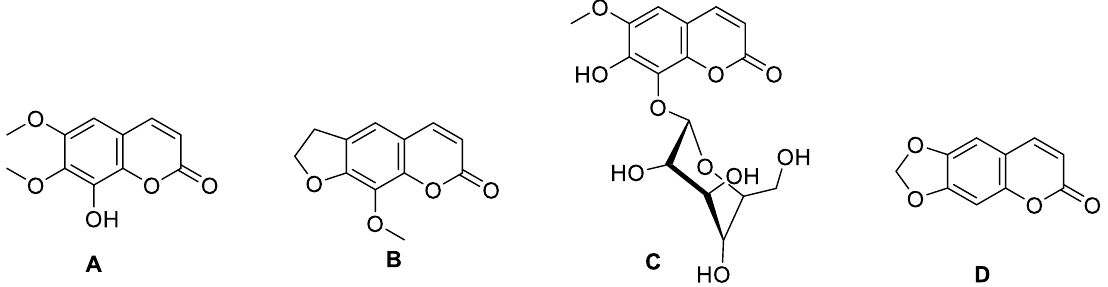
Figure 20. Chemical structures of fraxidine ( A ), methoxsalen (8-methoxypsoralen) ( B ), fraxin ( C ) and, ayapin (6,7-methylenedioxycoumarin) ( D ).